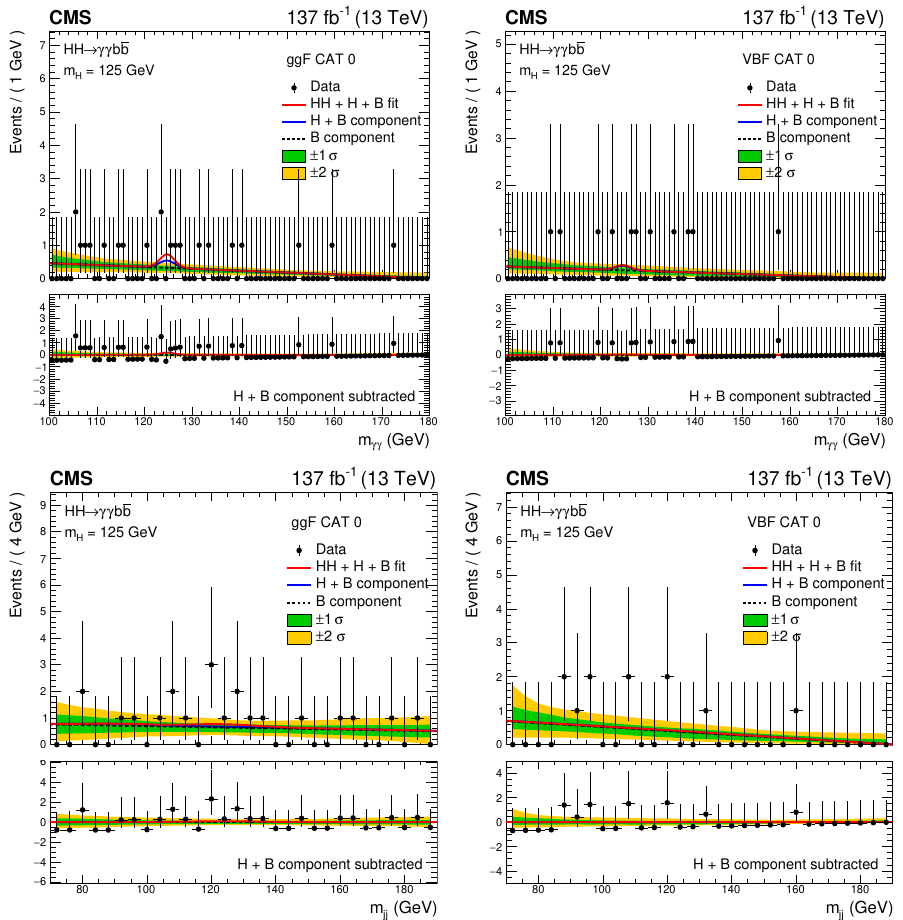
(upper) and m (lower) for the selected events in Figure 8 . Invariant mass distributions m γγ jj data (black points) in the best resolution ggF (CAT0) and VBF (CAT0) categories. The solid red line shows the sum of the fitted signal and background (HH+H+B), the solid blue line shows the background component from the single Higgs boson and the nonresonant processes (H+B), and the dashed black line shows the nonresonant background component (B). The normalization of each component (HH, H, B) is extracted from the combined fit to the data in all analysis categories. The one (green) and two (yellow) standard deviation bands include the uncertainties in the background component of the fit. The lower panel in each plot shows the residual signal yield after the background (H+B)